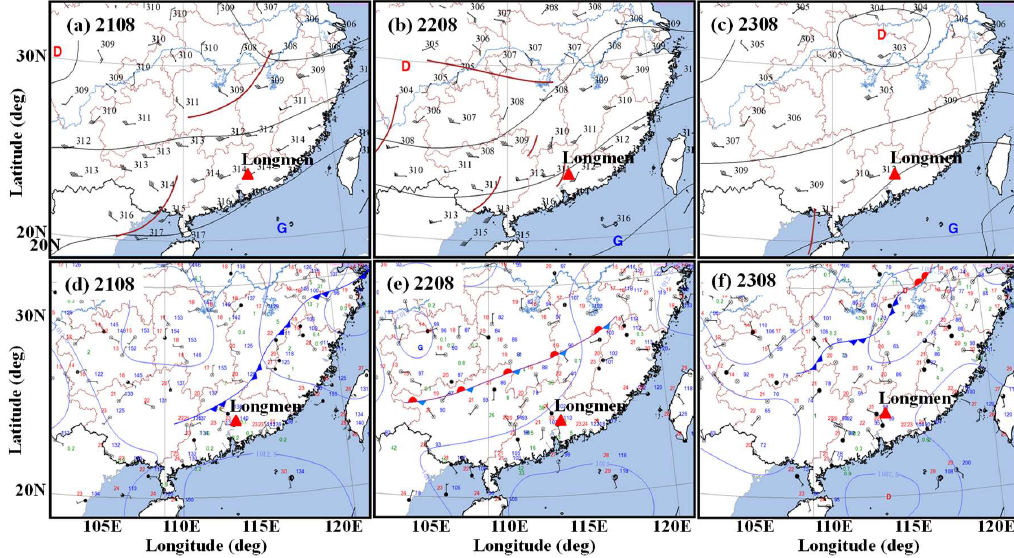
Figure 2. Weather charts on 21–23 April 2016: ( a )–( c ) at 700 hPa and ( d )–( f ) on the surface.